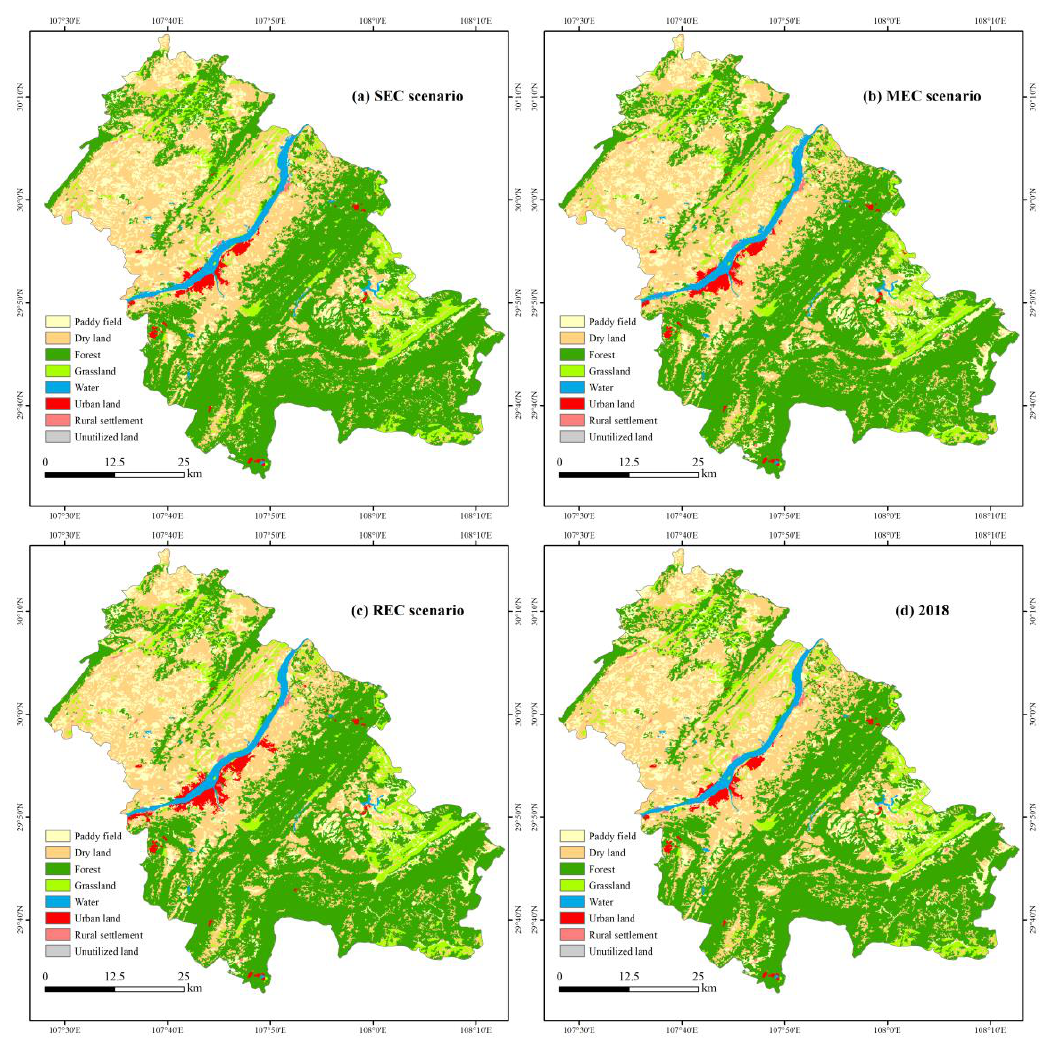
Figure 5. Optimization of the spatial configuration of land use types under ( a ) SEC scenario, ( b ) SME scenario, and ( c ) REC scenario in 2035 and ( d ) status quo in 2018.